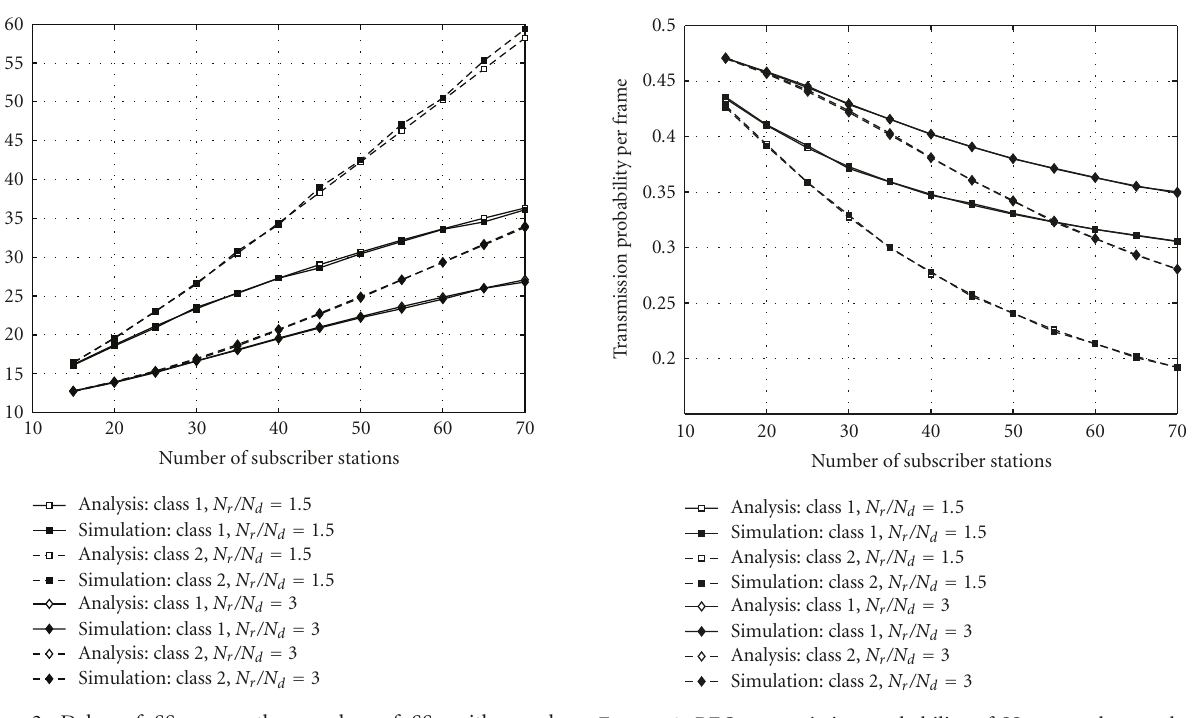
Figure 3: REQ transmission probability of SS versus the number of SSs with equal bandwidth allocation priorit, and di ff erentiated channel access parameters: W 0,1 = W 0,2 = N r , W x ,1 = 2 4 W 0,1, and W x ,2 = 2 8 W 0,2